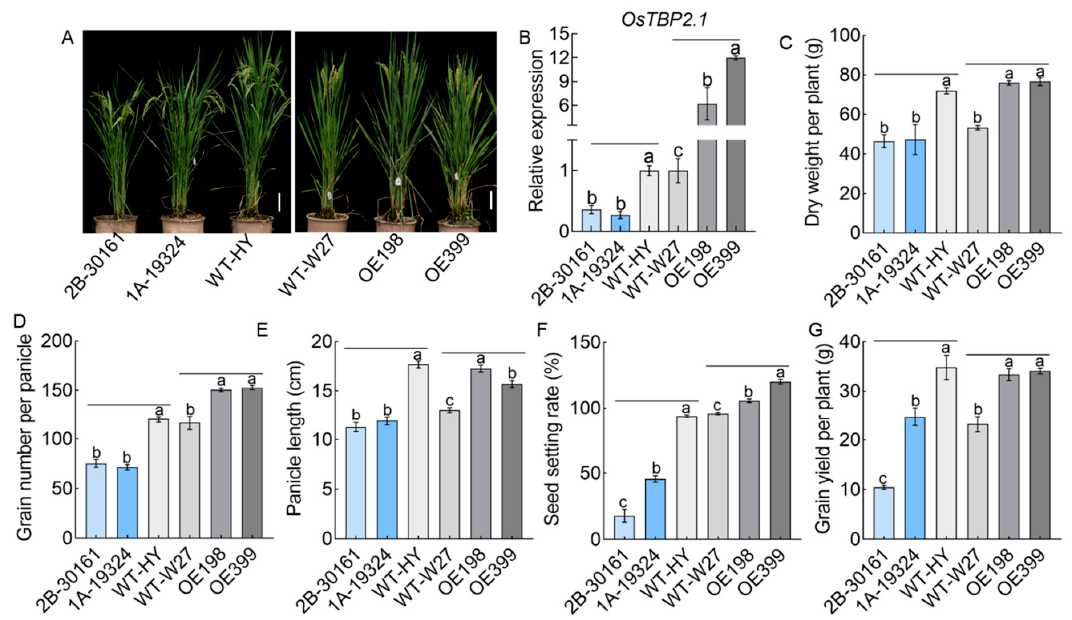
Figure 1. Phenotype of OsTBP2.1 T-DNA insertion mutant and OsTBP2.1 overexpression lines. ( A ) Characterization of T-DNA insertion mutant lines ( ostbp2.1 , 1A-19324 and 2B-30161) and OsTBP2.1 overexpression lines (OE, OE198 and OE399) in a field experiment. Wild-type, Huangyang (WT-HY) and Wuyunjing27 (WT-W27). (Bar = 20 cm). ( B ) The expression of OsTBP2.1 in the OE lines and ostbp2.1 lines. Error bars: SE (n = 3). At the maturity stage of OE lines and ostbp2.1 lines, dry weight ( C ), grain number per panicle ( D ), panicle length ( E ), seed setting rate ( F ), and grain yield per plant ( G ) were taken from the field. Error bars: SE (n = 5). The different letters indicate a significant difference between each other ( p <